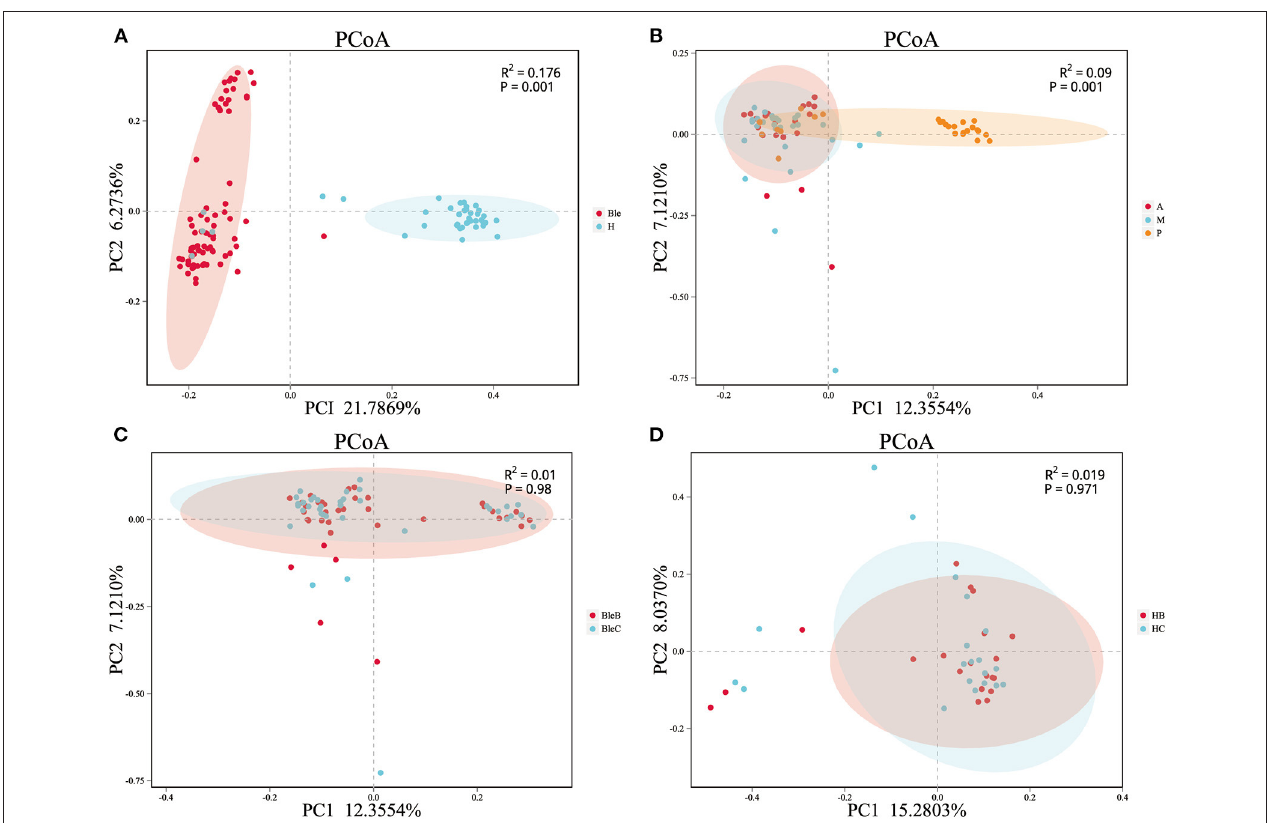
FIGURE 2 | The β -diversity analysis of the samples. PCoA and PERMANOVA were performed using the Bray-Curtis method. Each dot corresponds to a sample, and each color represents a group. (A) Division of all of the samples into the blepharitis group (Ble) and healthy control group (H). (B) The samples of patients with blepharitis were divided into the anterior blepharitis group (A), mixed blepharitis group (M) and posterior blepharitis group (P). (C) The samples of the patients with blepharitis were divided into the eyelid margin of the blepharitis group (BleB) and the conjunctival sac of the blepharitis group (BleC). (D) The samples of the normal subjects were divided into the eyelid margin of the healthy control group (HB) and the conjunctival sac of the healthy control group (HC).